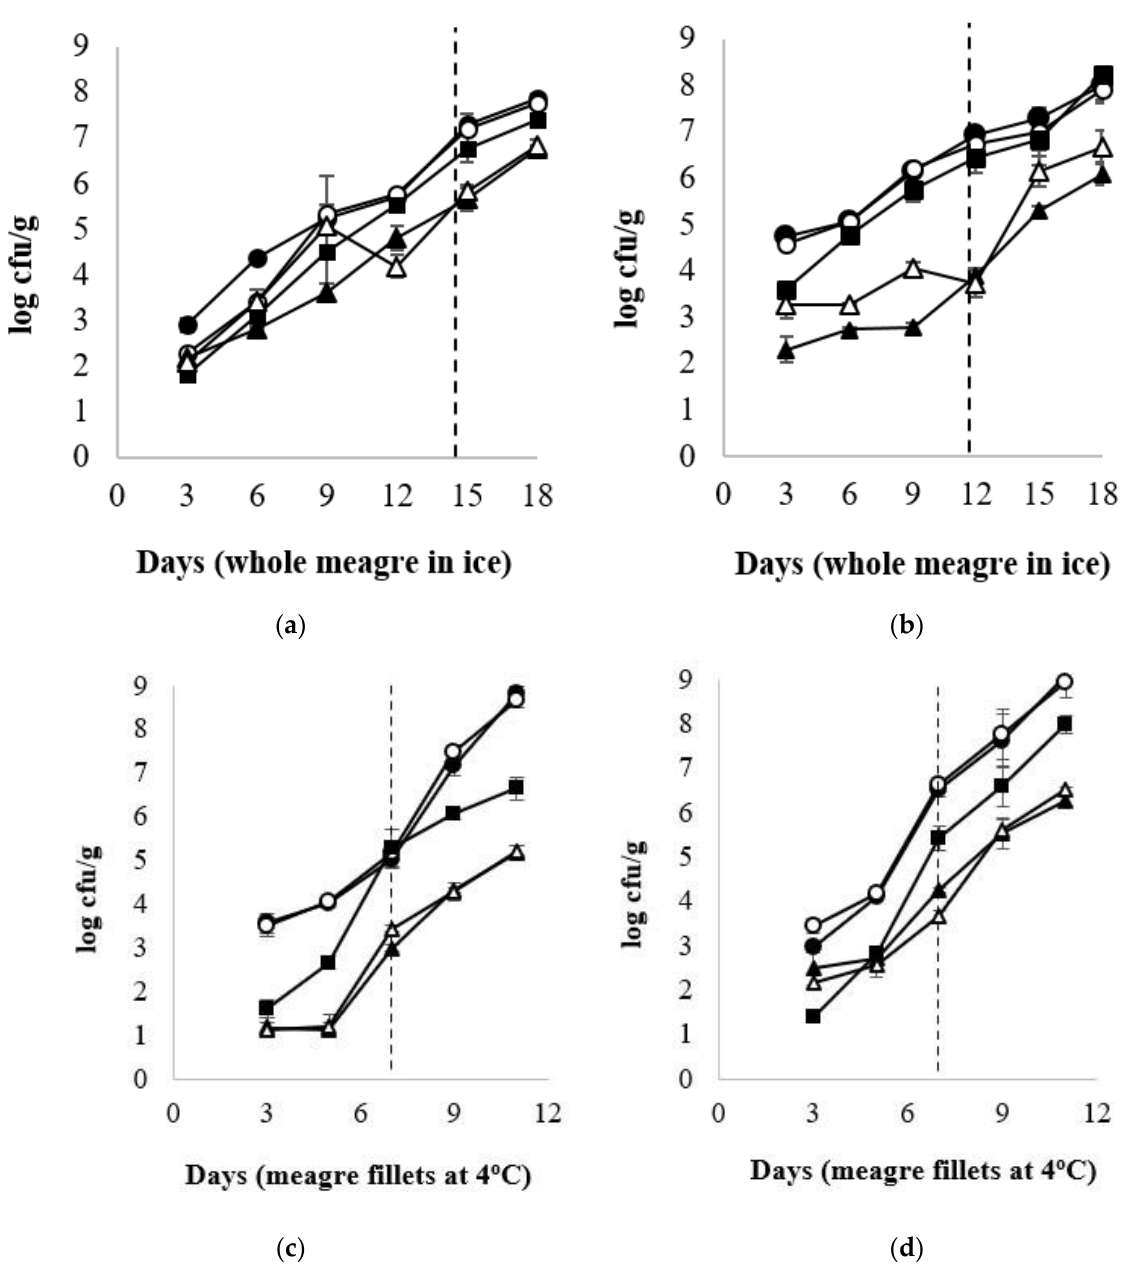
Figure 1. Microbial population changes of whole and filleted chill-stored meagre of January ( a , c ) and July ( b , d ), respectively. (●) Total Viable Counts (TVC), (o) Pseudomonas spp., ( ■ ) H 2 S producing bacteria, ( ▲ ) LAB—pH 6.4, and (Δ) LAB—pH 8 (●). Each point is the mean of six replicates. Error bars represent the standard error. The dashed vertical line indicates the end of shelf life.